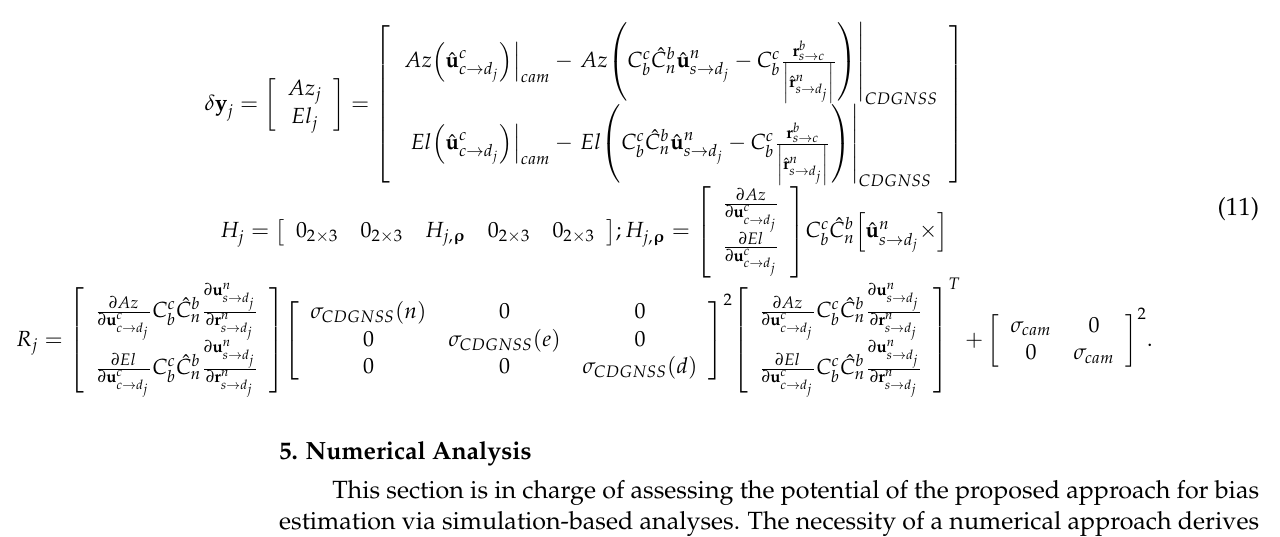
Figure 4. Formation geometry of a triplet of vehicles composed by one chief and two deputies. The local horizontal plane is depicted in blue. Projections on that plane are indicated with blue lines.